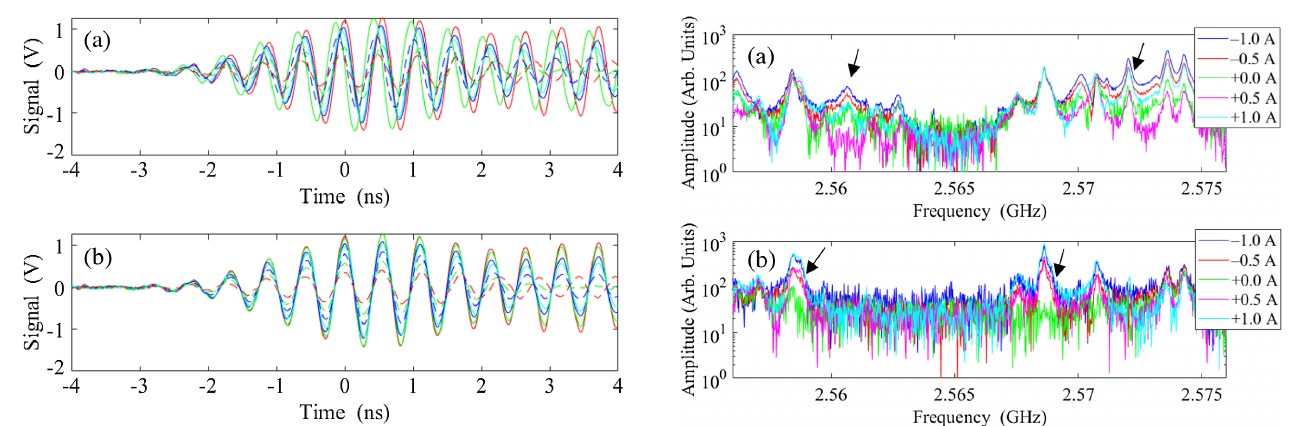
FIG. 17. Horizontal (a) and vertical (b) steering results showing polarization-dependent HOM variations in several modes from 2.555 to 2.575 GHz in CM2:C1 as indicated by the